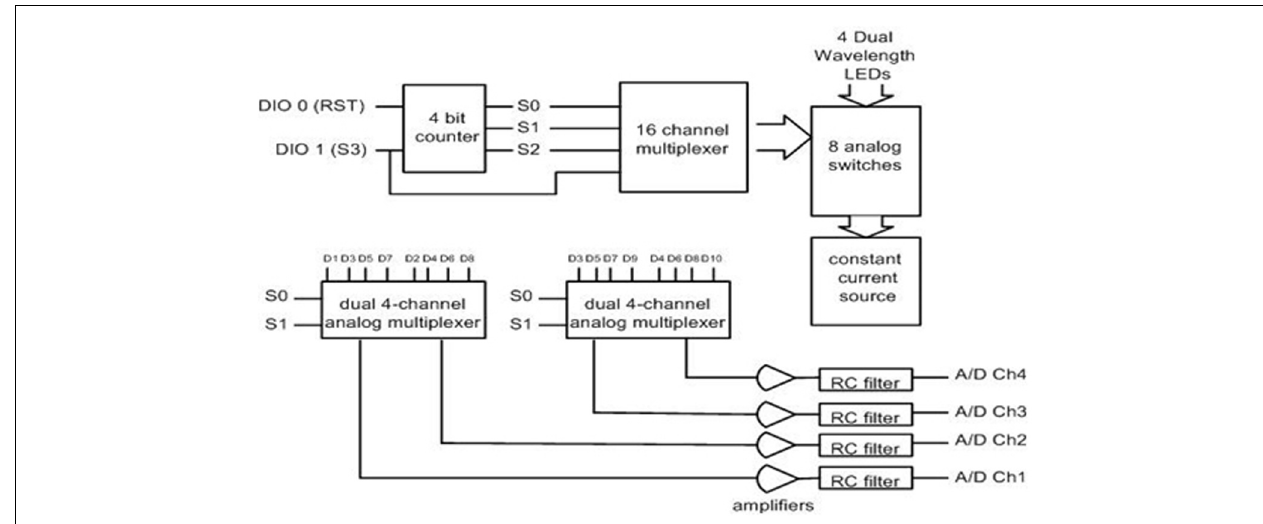
FIGURE 10 | Block diagram of the control